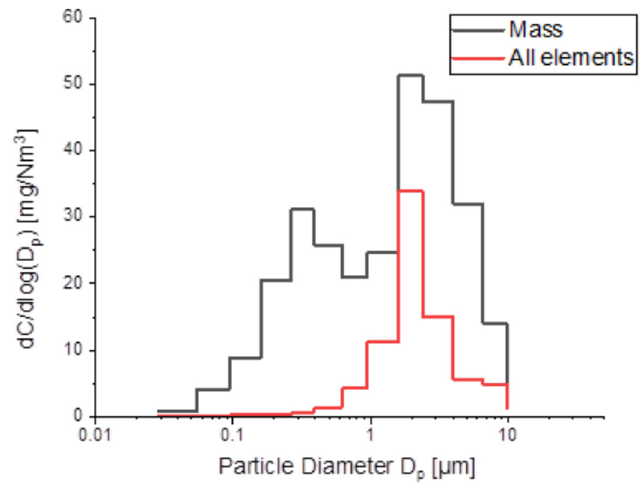
Figure A1. Size distribution of PM mass [(mg/Nm 3 )] (dark grey line) and of total mass explained by chemical elements determined [(mg/Nm 3 )] (red line) over the 13 size fractions.